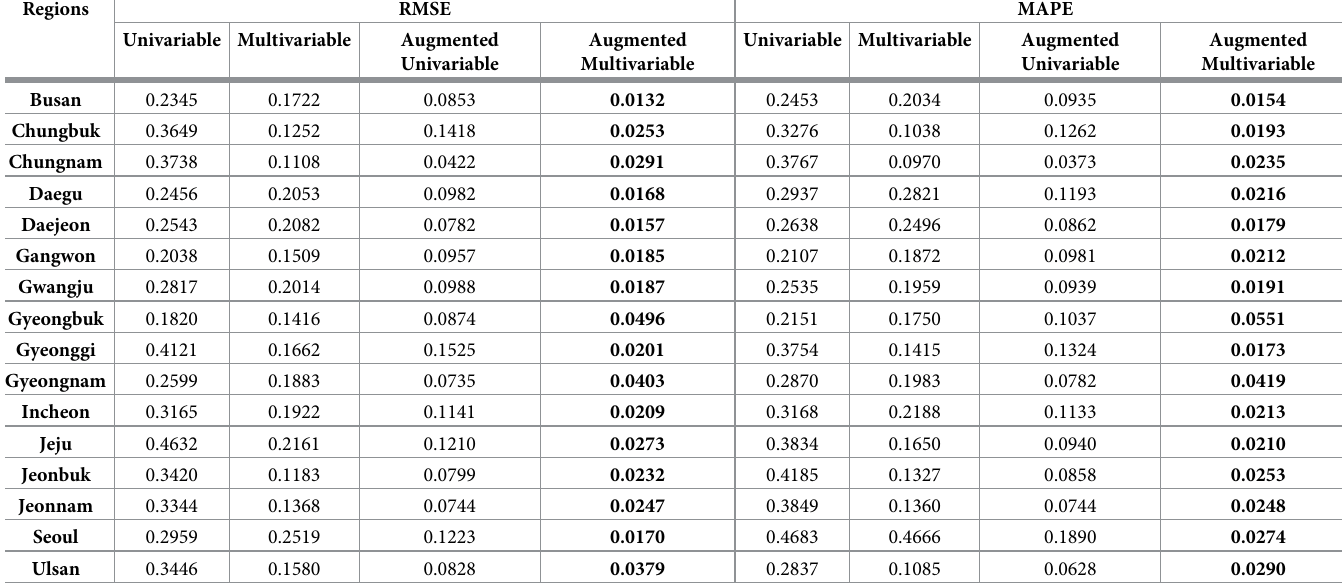
Table 4. Evaluation of forecasting performance of CNN-LSTM. Regions